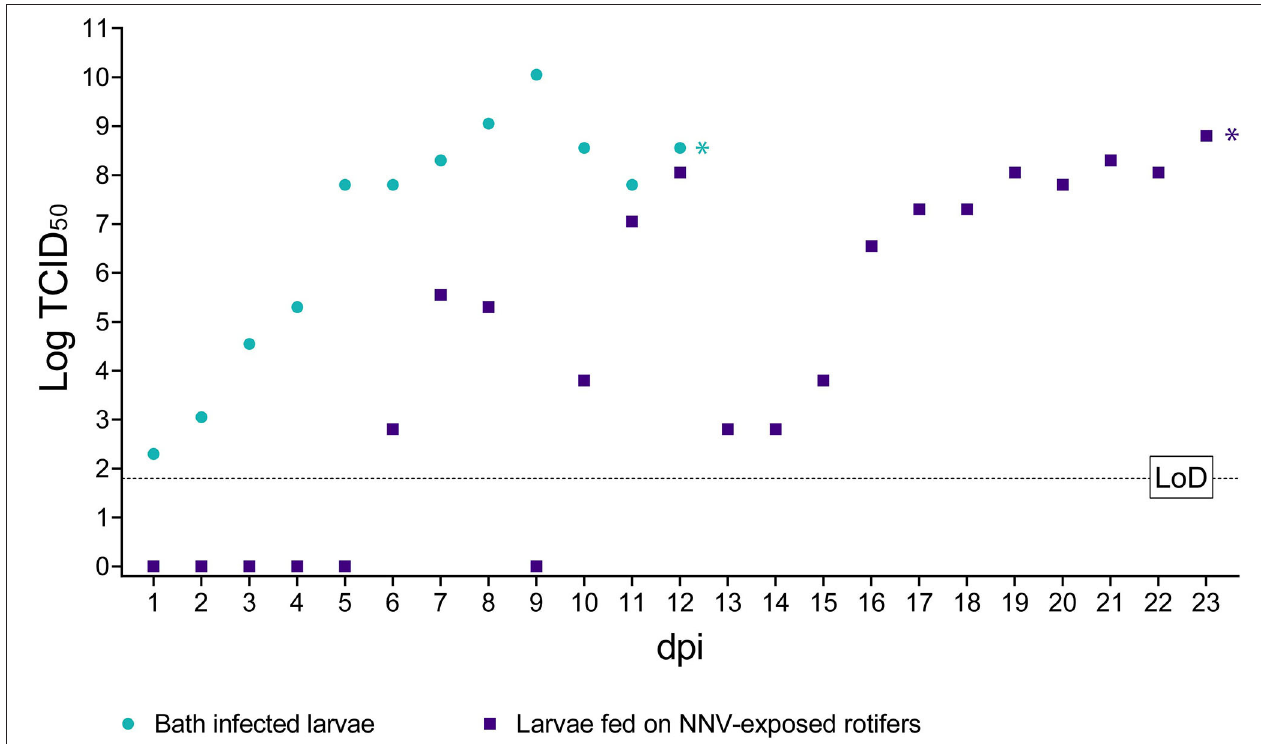
FIGURE 4 | Infectious titer of NNV detected in challenged larvae. The x -axis represents the observation period expressed as days post-infection (dpi). The y -axis represents quantified viral load expressed as Log 10 of TCID 50 /ml. Bath infected larvae values are depicted as green circles. Values of larvae fed on NNV-exposed rotifers are depicted as purple squares. A dashed horizontal line indicates the limit of detection (LoD). * Indicates the achievement of total mortality in both